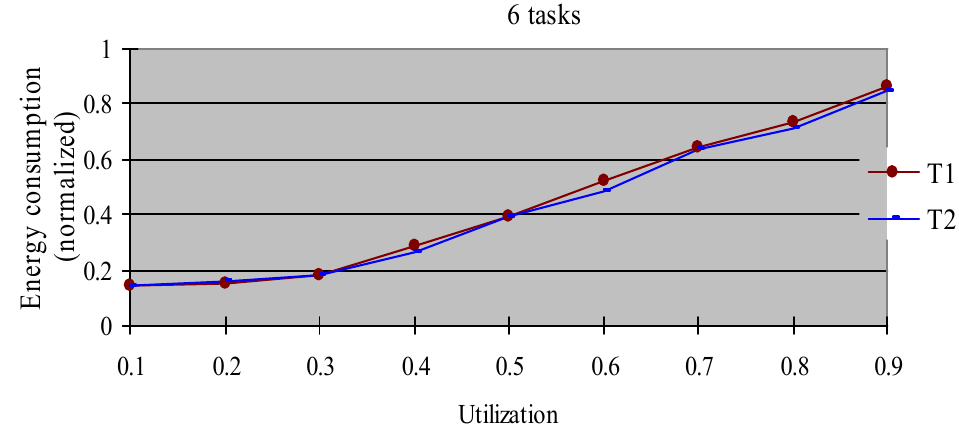
Figure 6. Normalized unweighted energy consumption when using different energy-saving algorithms.